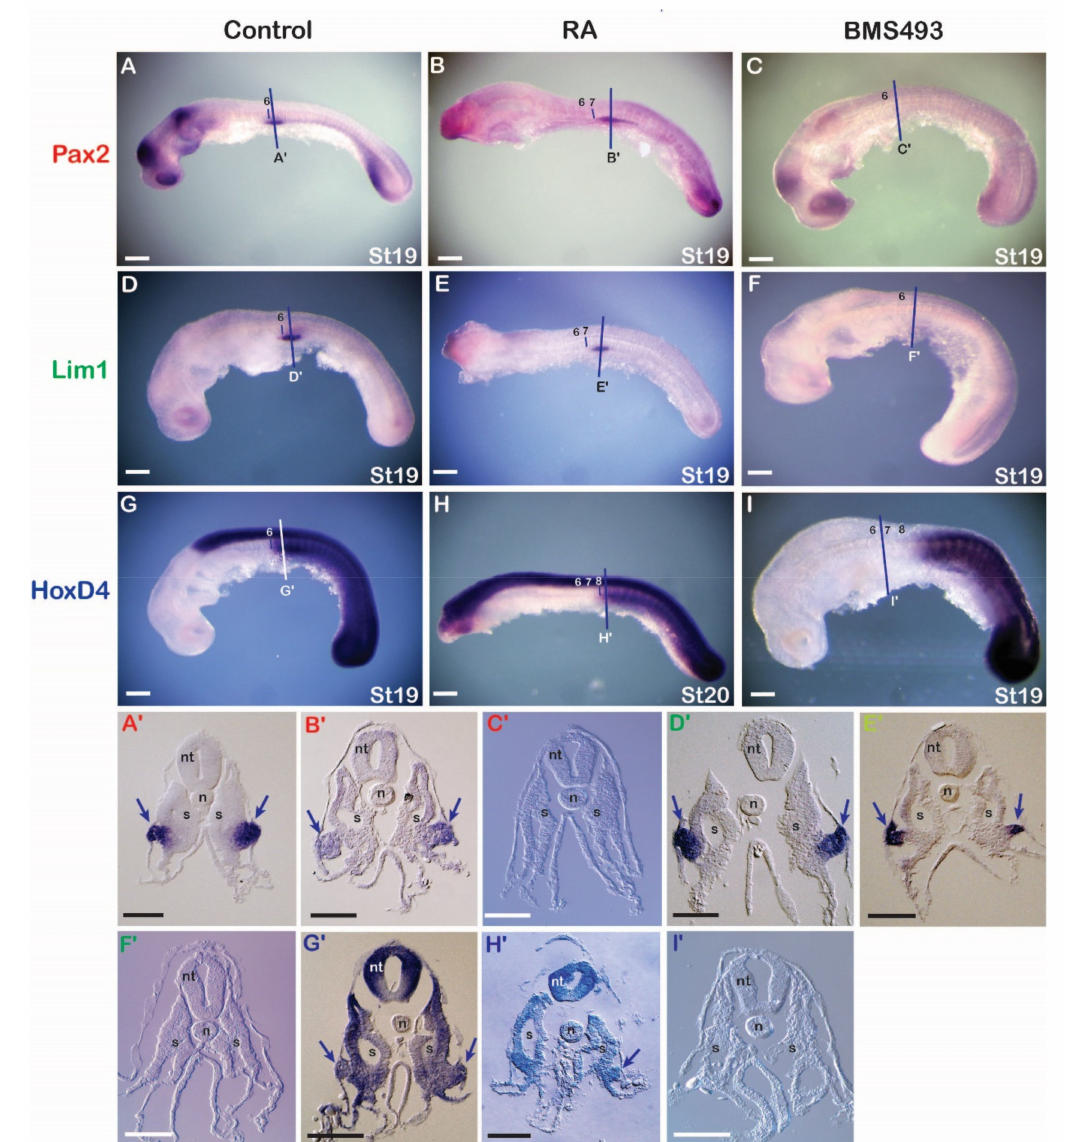
Figure 3. Retinoic acid signaling and the regulation of nephric genes in the catshark. ( A , D , G ) Control embryos assayed for expression of Pax2 ( n = 15/15) ( A ), Lim1 ( n = 15/15) ( D ), and HoxD4 ( n = 10/10) ( G ). ( B , E , H ) Embryos treated with retinoic acid (RA) and assayed for expression of Pax2 ( n = 9/10) ( B ), Lim1 ( n = 10/10) ( E ), and HoxD4 ( n = 10/10) ( H ). ( C , F , I ) Embryos treated with BMS493, an inverse agonist of retinoic acid receptors, and assayed for expression of Pax2 ( n = 15/15) ( C ), Lim1 ( n = 10/12) ( F ), and HoxD4 ( n = 9/10) ( I ). Somites are marked by numbers. Cross sections are at the level of the lines in the whole mounts. Arrows indicate the formation of the pronephros. n, notochord; nt, neural tube; S, somite; st, stage. Scale bars in ( A – I ) are 500 µ m and scale bars in ( A’ – I’ ) are 100 µ